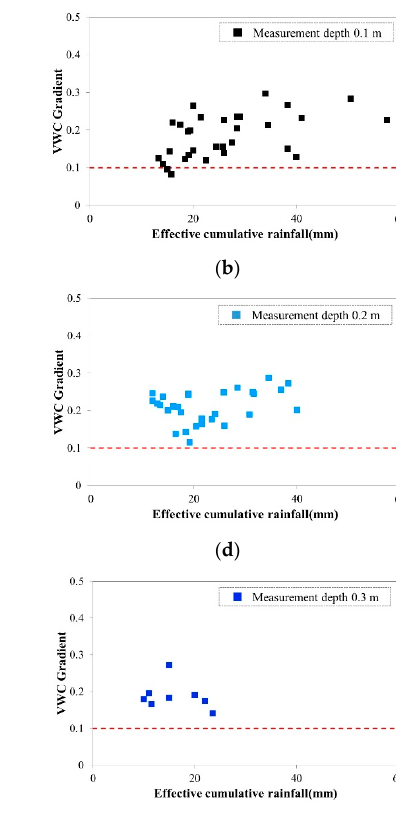
Figure 3. Schematic representation of the flume test equipment used for measurements at a slope angle of 35°. Table 1. Physical properties of the soil used in flume tests.